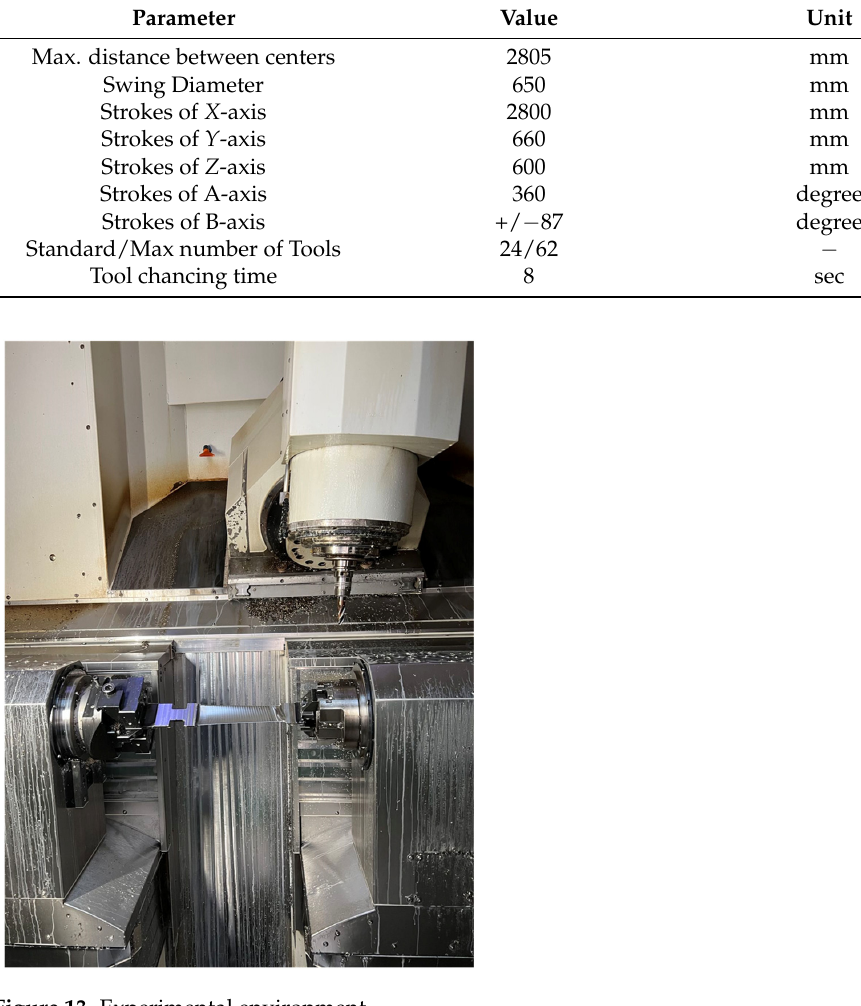
Figure 13. Experimental environment.